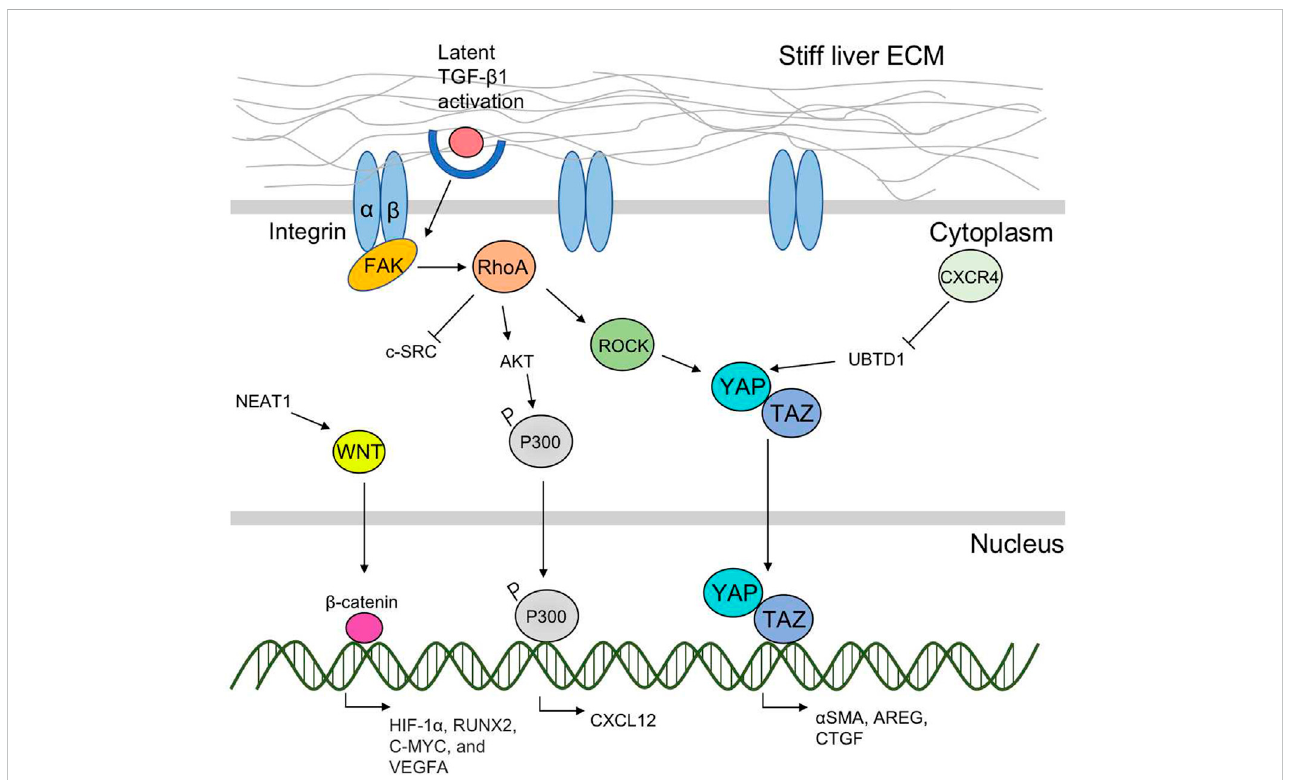
FIGURE 2 A scheme of liver ECM stiffness-regulated sensing and mechanotransduction pathways. Liver ECM-derived mechanical cues are mainly sensed by integrin-based FAs located on the cell surface. The intercellular mechanotransduction pathways including the RhoA/ROCK and the YAP/TAZ signaling ways are further activated and transfer the mechanical cues into nucleus to target pro fi brotic genes. RhoA/ROCK interacts with YAP/TAZ, and promotes their nucleartranslocation.RhoAactivatesAKT,promotesP300phosphorylation,andCXCL12expression.Matrixstiffness-inducedCXCR4expressioninhibits UBTD1 and activates YAP. The nuclear translocation of YAP/TAZ promotes expression of α -SMA, AREG, and CTGF. Other mechanotransduction pathway includes NEAT1-WNT/ β -catenin